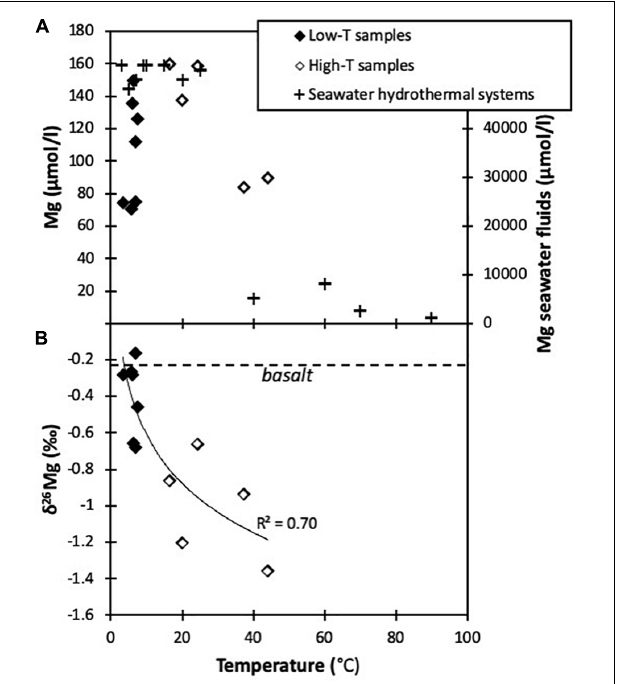
FIGURE 3 | (A) The effect of temperature on Mg concentrations during hydrothermal removal. At low temperatures, there is no effect, but as temperatures exceed 30 ◦ C, Mg concentrations both in Myvatn and seawater samples (Mottl and Wheat, 1994) rapidly decrease (note different scale for seawater samples). (B) This effect causes significant Mg isotope fractionation in the Myvatn hydrothermal springs. The trend line is logarithmic to correspond to stable isotope fractionation